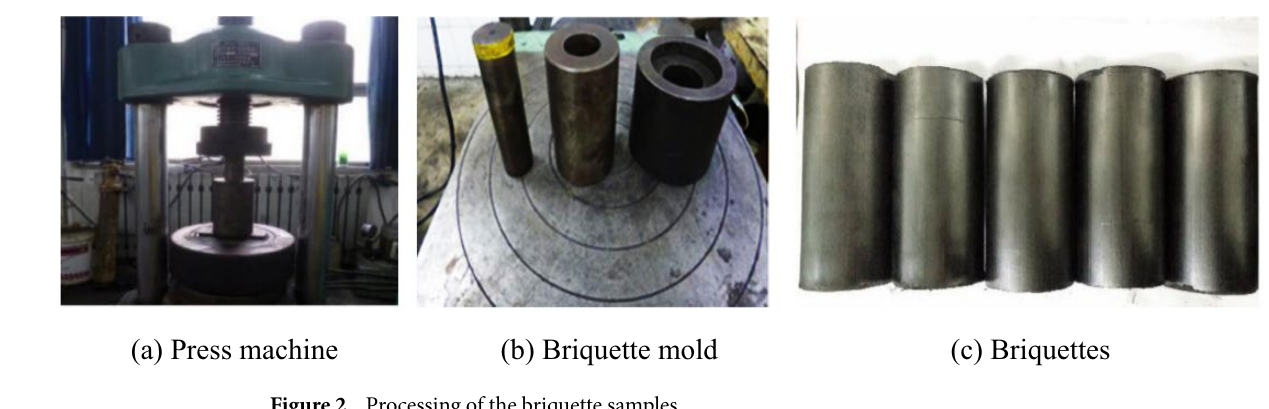
Figure 2. Processing of the briquette samples.